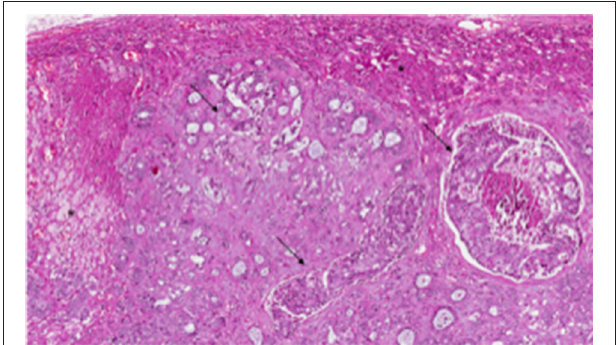
FIGURE 1 | CT-scan of the abdomen showing a 5cm diameter mass of the left adrenal gland 37 months after a quadrantectomy for an infiltrating ductal carcinoma of the breast (A) and a metachronous 2cm diameter mass of the right adrenal 15 months after left adrenalectomy (B) .